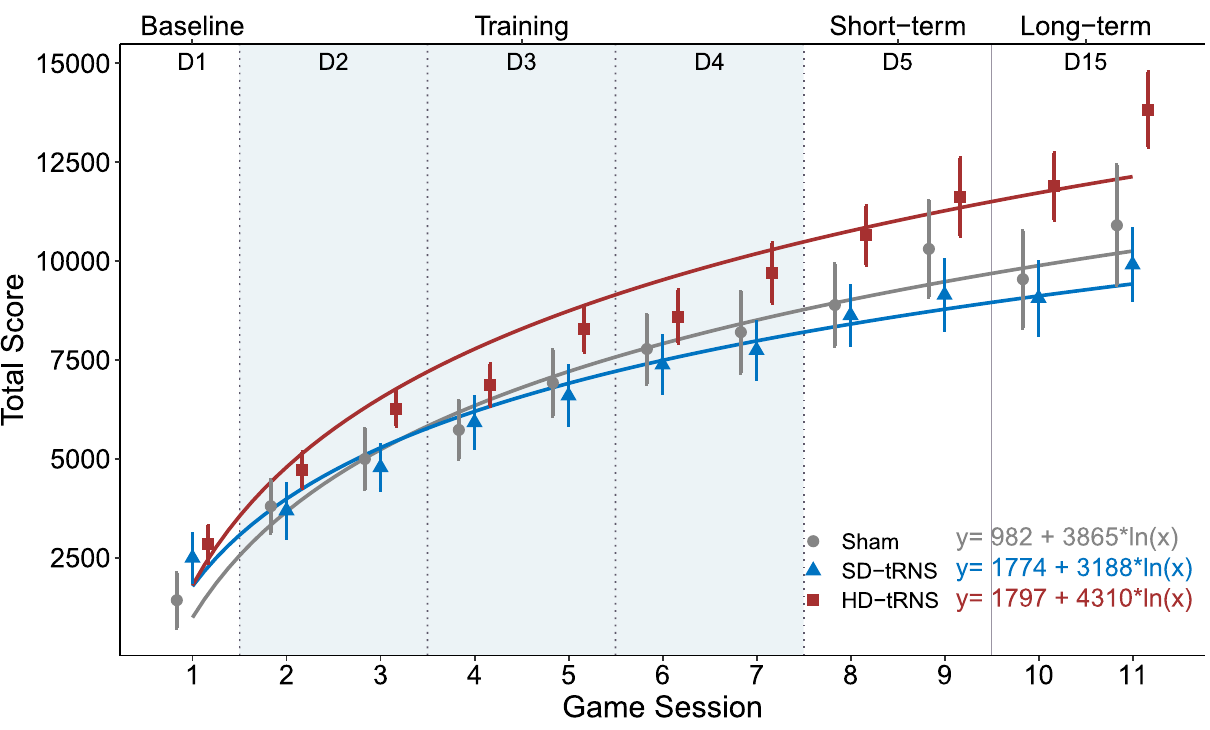
Figure 2. Mean total scores for Space Fortress game (with standard error bars) per group across game sessions. The fitted ln model across game sessions and for each group is presented in the lower right part. D day.